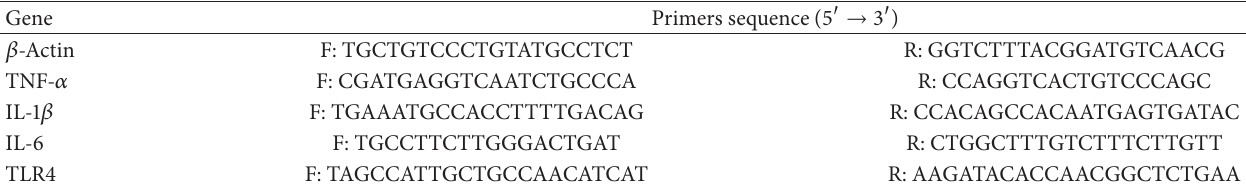
Table 2: Sequence of primers used in current investigation in